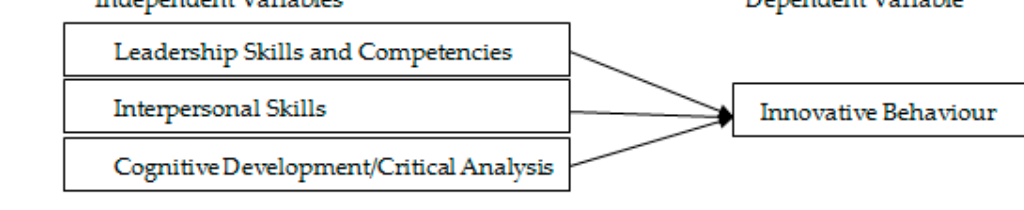
Figure 1. Research